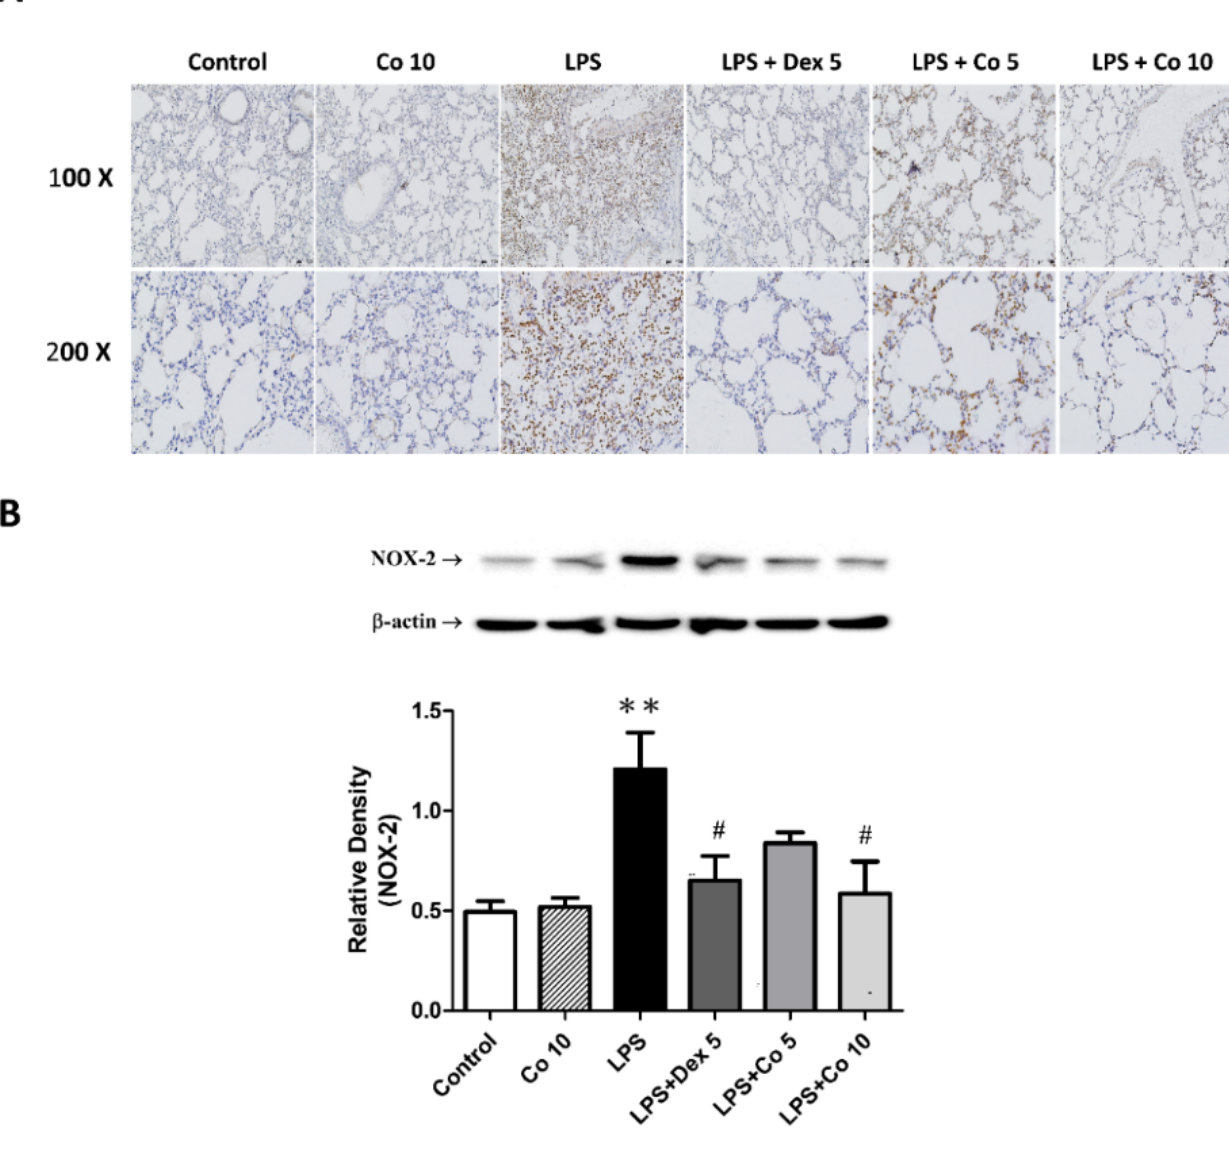
Figure 6. Effects of corilagin on NOX2 expression in LPS-induced ALI . After intratracheal LPS challenge for 30 min, the mice were administered with Dex (5 mg/kg), corilagin (5 and 10 mg/kg), or equal volume of saline intraperitoneally. Mice were sacrificed, and lung tissues were obtained after 6 h of LPS challenge. ( A ) Immunohistochemical staining of lung NOX2 expression (brown) from six groups. Typical images were chosen from each experimental group (100 × and 200 × magnifications are shown). ( B ) The expression levels of NOX2 were detected by Western blot analysis. The bands were analyzed using densitometry, and each value represents the mean ± SEM ( n = 6 mice/group). ** p < 0.01 vs. control; # p < 0.05 vs. LPS alone.